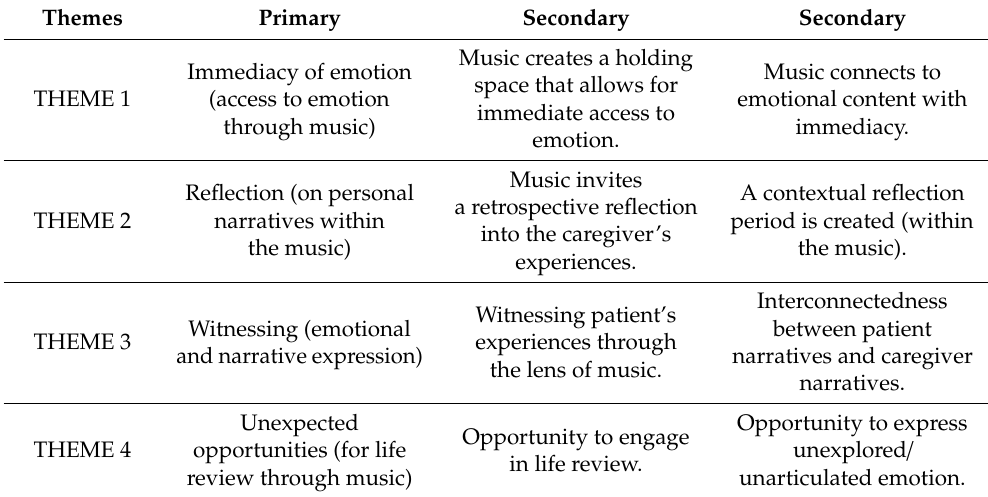
Table 3. Primary and secondary themes for